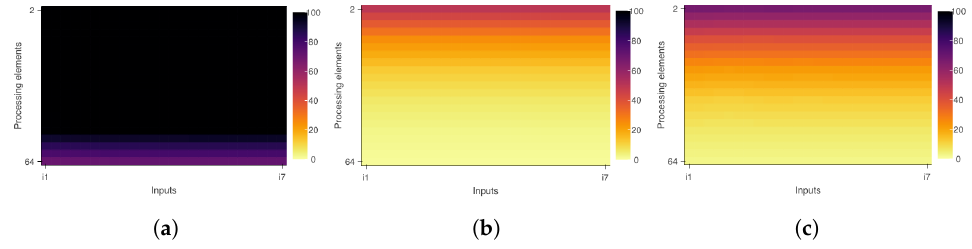
Figure 3. Efficiency diagrams and impact of inner regions on program scalability. (x-axis = inputs; y-axis = number of threads). ( a ) First region diagram. ( b ) Second region diagram. ( c ) Whole program diagram.